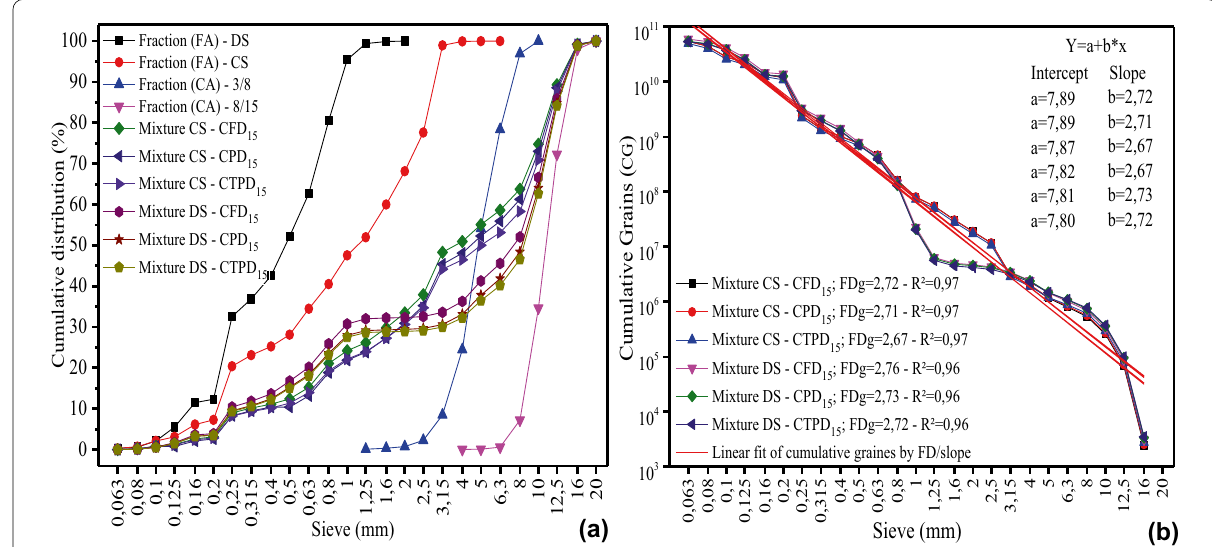
Fig. 3 Identifications of D 15 concrete granular curves using the fractal dimension FD g . a Granulometric curves, b fractal straight